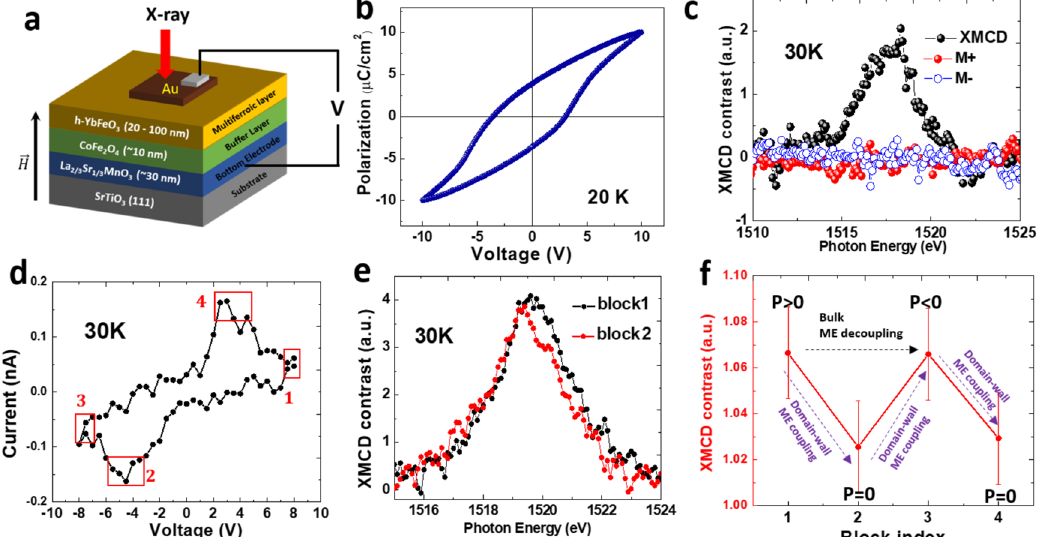
Figure 5. ( a ) Schematic diagram of the measurement setup. ( b ) Ex-situ ferroelectric hysteresis loop of h-YbFeO 3 films. ( c ) The remnant XMCD spectrum and the contrast of x-ray absorption before and after the polarization reversal for both remanent magnetization states (M + and M −) of the Yb M 5 edge. ( d ) In-situ measurement of switching current with voltage in h-YbFeO 3 film during XMCD measurement at 30 K. The blocks 1–4 correspond to the range of voltage for averaging the XMCD signals. ( e ) Remanent XMCD spectra of Yb M 5 edge when the film is under positive saturated polarization (block 1) and multidomain state near negative coercive voltage (block 2). ( f ) Integrated XMCD contrasts at the Yb M 5 edge and polarization states during different stages of ferroelectric